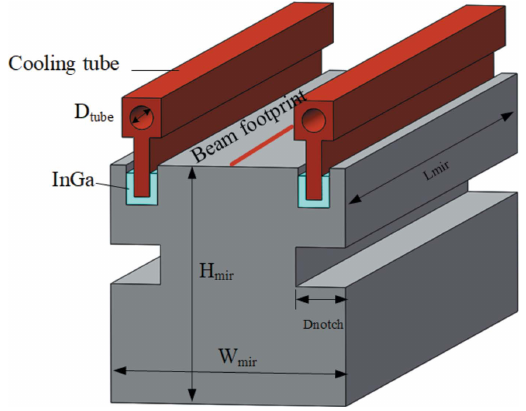
Figure 1 Schematic diagram of the cooling structure, including single-crystal silicon substrate, copper tube and In–Ga bath.